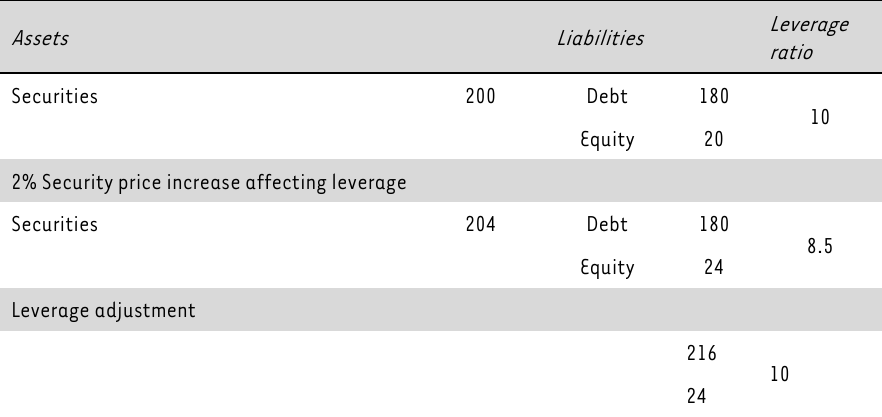
TABLE 1: Balance sheet management through leverage targeting